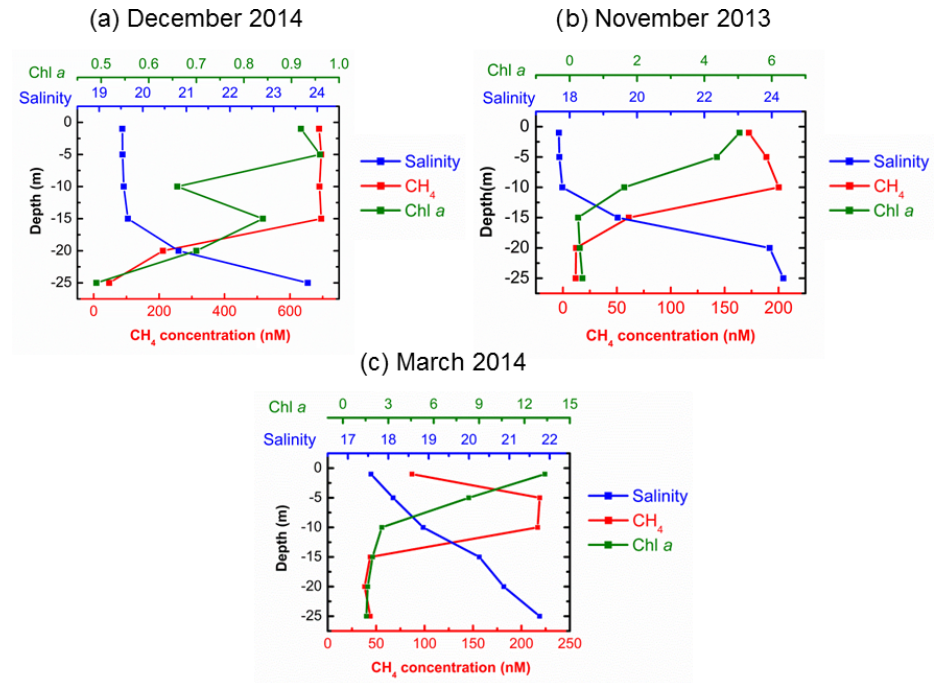
Figure 4. Vertical distribution of Chlorophyll a , salinity and CH 4 concentrations in the water column in December 2014 (a) , Novem- ber 2013 (b) and March 2014 (c) .